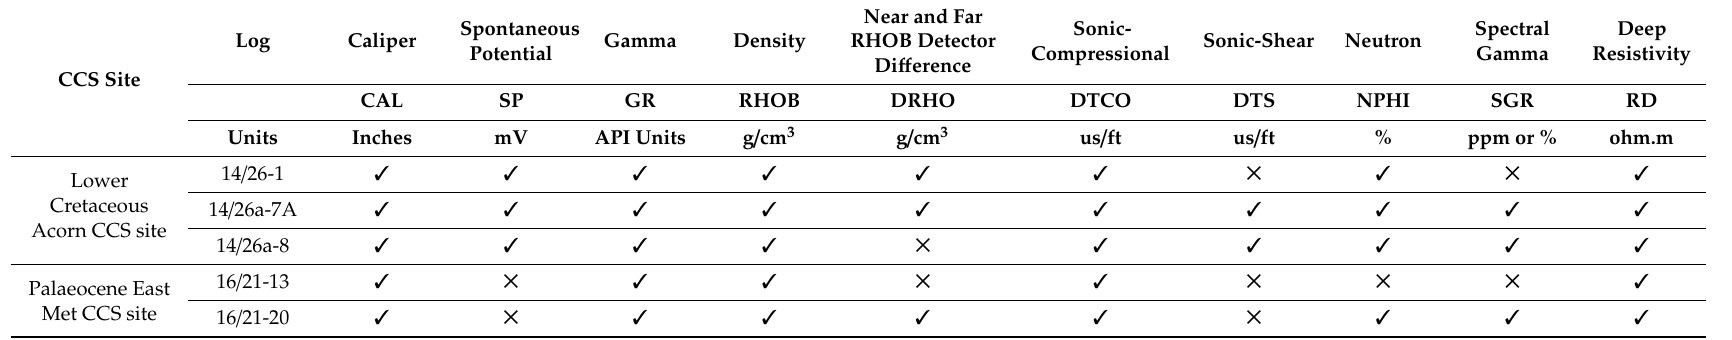
Table 1. Summary of wireline log availability for the five wells used in this study. Abbreviations and units are also